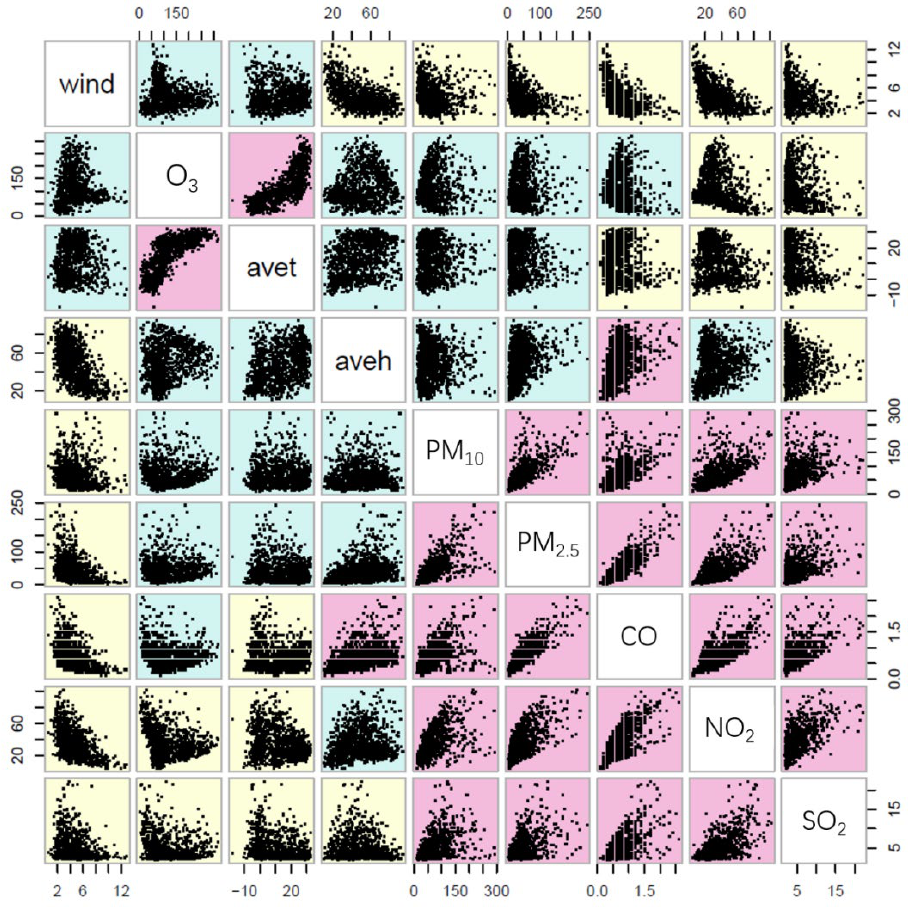
Figure 1. Correlation matrix analysis of environmental variables in Beijing (2018 − 2020); the strongest correlation is indicated in red, followed by yellow, with the weakest indicated in blue.